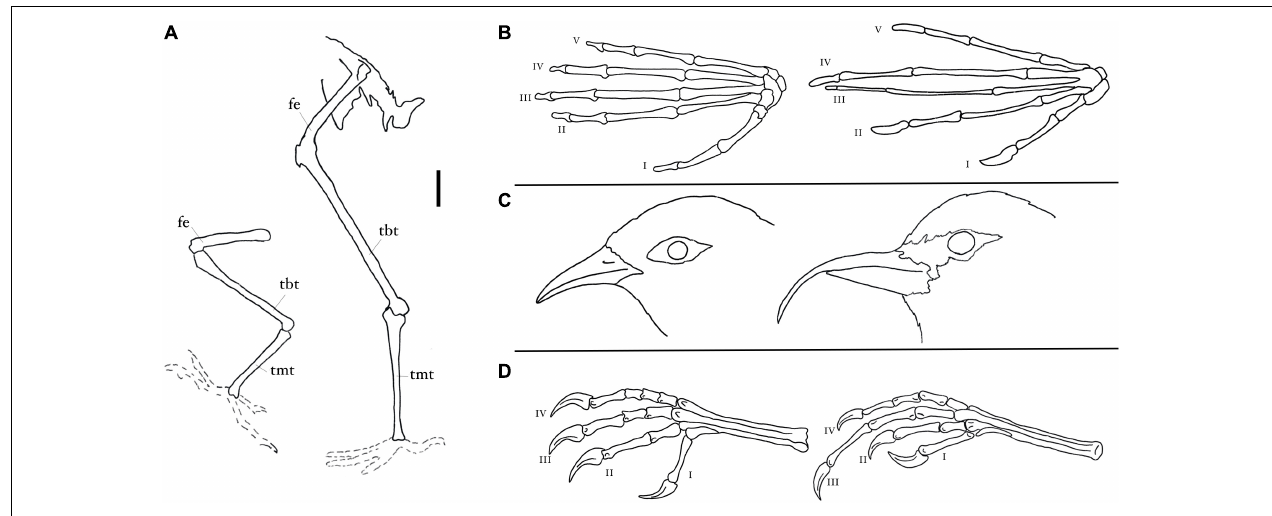
FIGURE 5 | (A) Comparison of the left leg skeletal anatomy between the picid Melanerpes aurifrons (Golden-fronted Woodpecker) (left), and the passerine Turdus migratorius (American Robin) (right). Both species average nearly the same wing chord length (130 mm), and average mass ( M. aurifrons : 73–99 g, T. migratorius : 60–94 g), yet the length of the tarsometatarsus ( M. aurifrons : 22 mm, T. migratorius : 34 mm) and tibiotarsus is greatly reduced compared to other taxa with similar body size in the scansorial M. auriforns and other picids, sittids, and furnarids. Scale bar = 10 mm. fe, femur; tbt, tibiotarsus; tmt, tarsometatarsus. (B–D) The various hypertrophied appendages of wood-boring and probing organisms compared with similar relatives that occupy other niches. All organisms on the right-hand side column demonstrate a deviation from the average proportional morphology of many closely-related taxa, whether the appendage be either the manus (top), bill (middle), or pedes (lower). (B) Two lemurs, the Indri ( Indri indri ) (left) and the Aye-aye ( Daubentonia madagascariensis ) (right). (C) Two Hawaiian honeycreepers, the Apapane ( Himatione sanguinea ) (left) and “Akiapola”au ( Hemignathus munroi ) (right). (D) Two Cretaceous enantiornithines, Rapaxavis pani (left) and Elektorornis chenguangi (right). Figures not drawn to